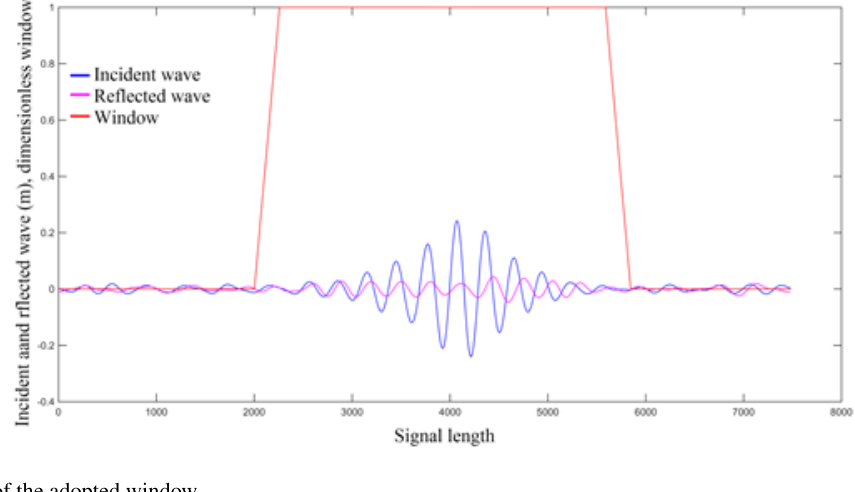
Figure 15. Example of the adopted window.